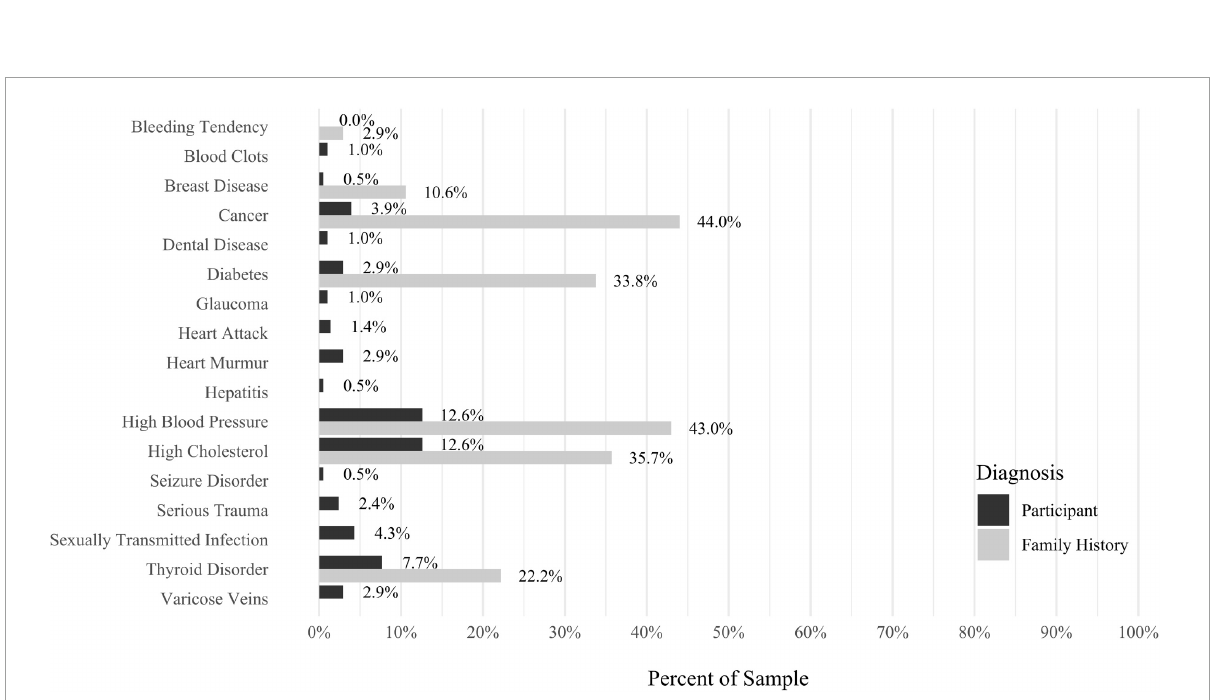
FIGURE17 Rates of medical health problems: other problems. N = 207. Medical health problems were not listed if they had a prevalence rate of 0% for both the “Participant” and “Family History” categories. AMC, caused by another medical